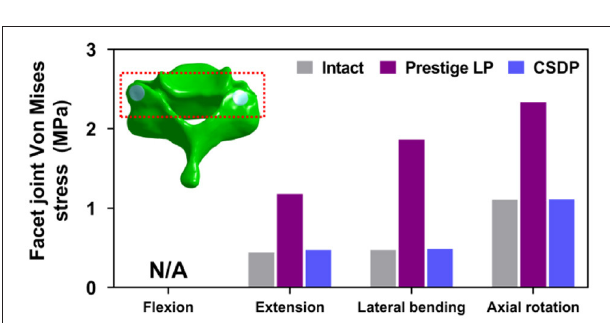
FIGURE 9 | Facet joint force analysis of the cervical subtotal discectomy prosthesis (CSDP) finite element (FE)